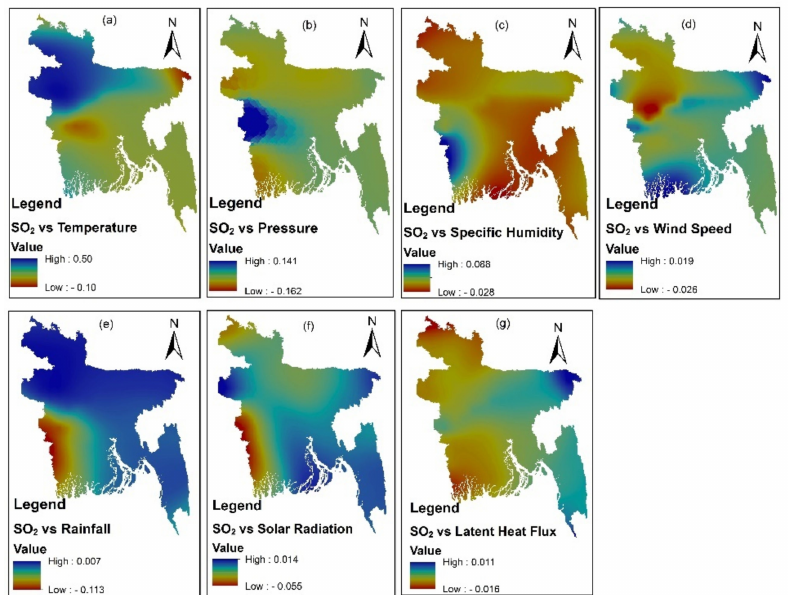
Figure 10. Spatial representation of the relationship between SO 2 and meteorological variables using the geographically varying coefficients from GWR modelling over Bangladesh during 2015–2020: ( a ) temperature, ( b ) pressure, ( c ) specific humidity, ( d ) wind speed, ( e ) rainfall, ( f ) solar radiation, and ( g ) latent heat